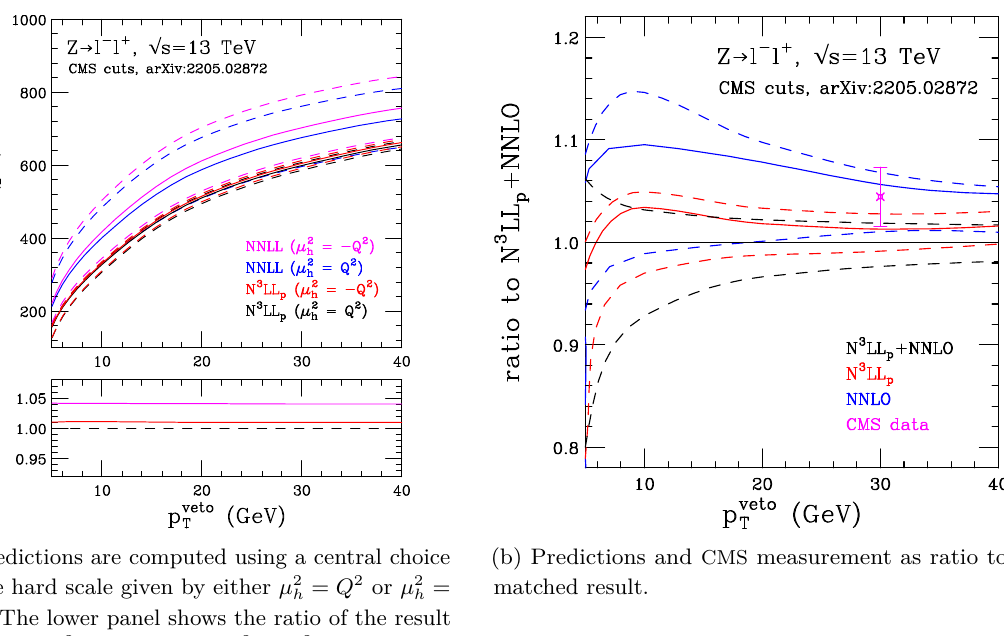
Figure 9 . Comparison of NNLL and N 3 LL p predictions for Z production as a function of the jet veto, using the setup of ref. [38] (central predictions solid, uncertainty estimate according to the text,